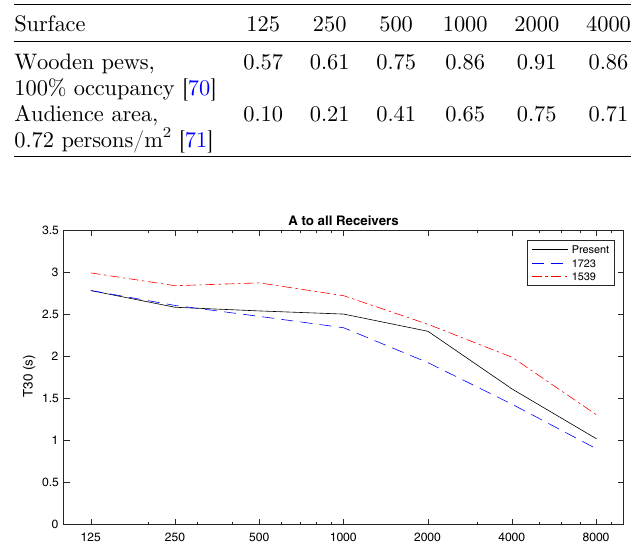
Table 6. Absorption coef fi cients by octave band center frequency (Hz) for additional surfaces in the full-occupancy Thomaskirche GA models.